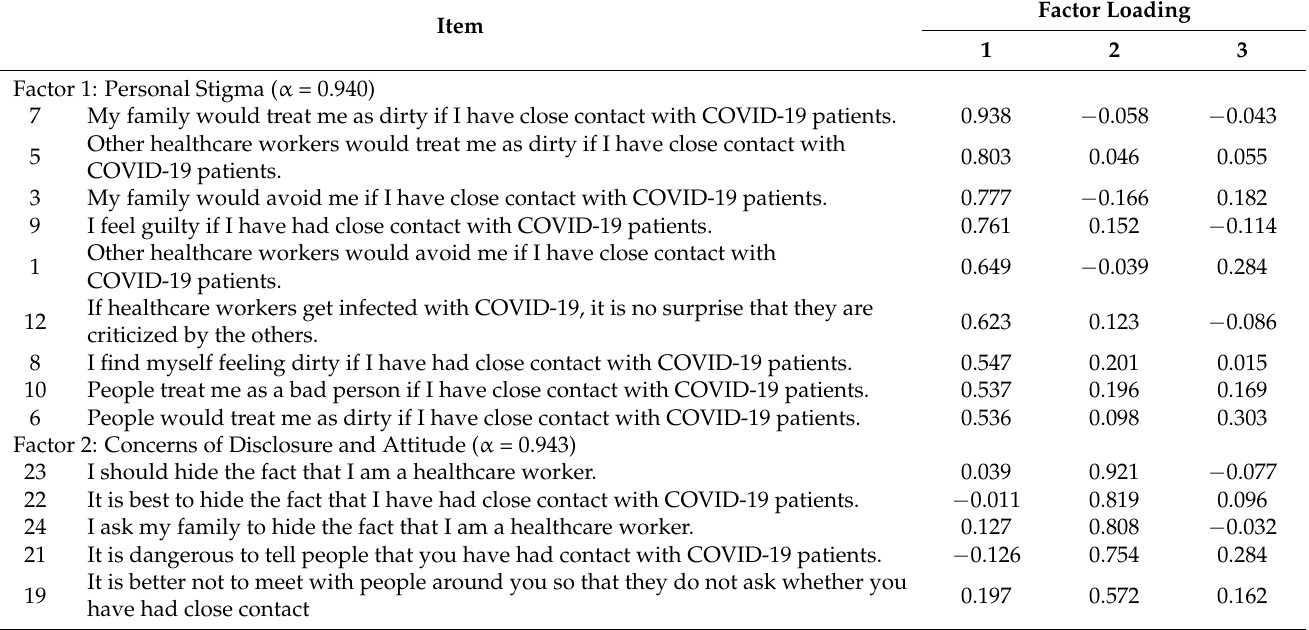
Table 2. Results of the exploratory factor analysis and Cronbach’s α coefficients ( n = 500).